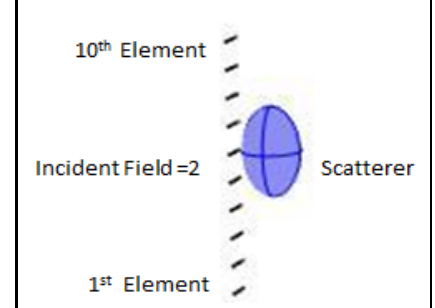
Figure 13: Convergence of decided